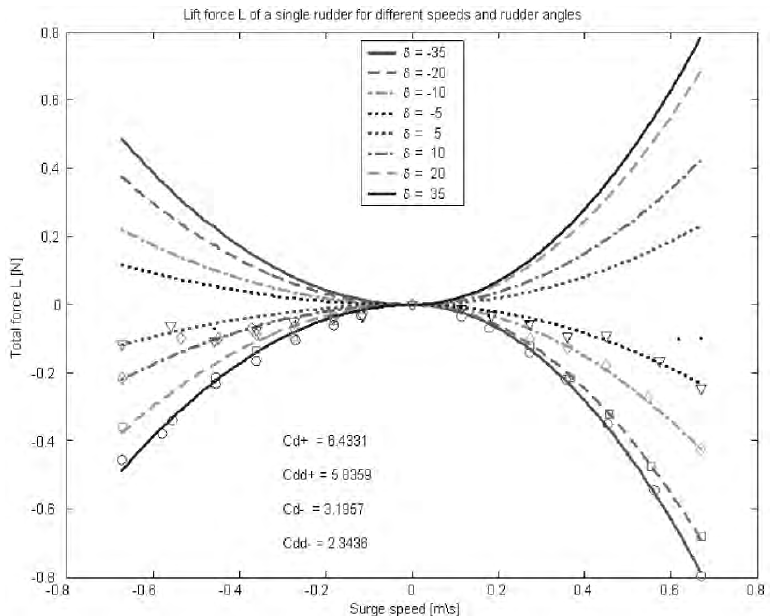
Figure 10. Curve interpolation to the measured lift forces for the rudders. Notice that CyberShip II generate more lift force in forward motion than backward